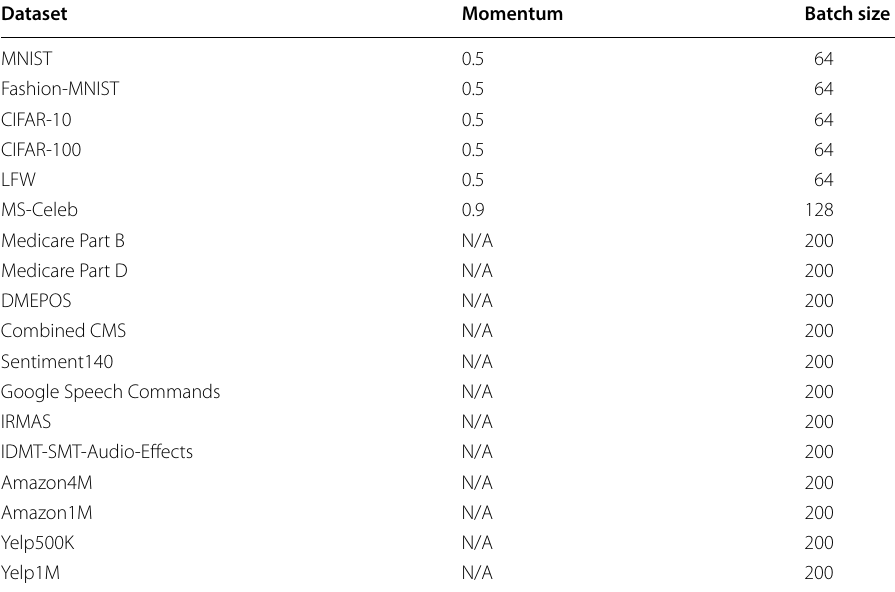
Table 2 Momentum and batch size per dataset